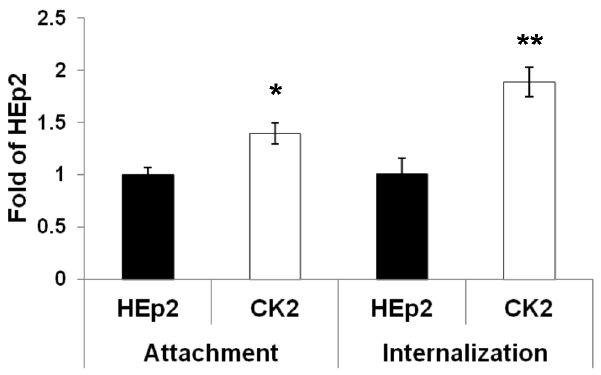
Figure 3. Ad5wt shows slightly higher attachment and internalization in cisplatin-resistant CK2 cells comparing to parental HEp2 cell line. Cells were incubated with Ad5wt at MOI 1000 for 40 minutes on ice. To measure attachment, unbound viruses were removed and cells were scraped off and pelleted. To measure internalization, unbound viruses were removed and cells were incubated at 37 u C for 40 minutes, trypsinized and pelleted. Total DNA (cellular plus viral) was extracted from cells and used as a sample for quantification of viral DNA by real-time PCR using a region within the hexon as the target sequence. The cell-derived DNA content per PCR reaction was normalized by a second real-time PCR assay targeting the GAPDH gene. The results presented are representative of three independent experiments with similar results 6 standard deviation. Asterisks indicate significant differences (*, P , 0.05; **, P ,